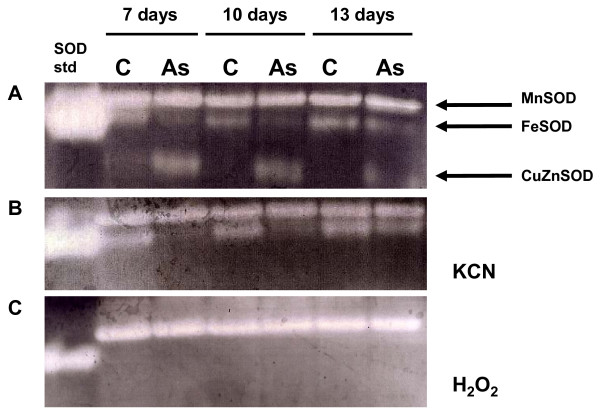
SOD activity in Arabidopsis thaliana 'Col' grown on medium containing 100 μM potassium arsenate. A, superoxide dismutase activity without inhibitors, B, Gels were preincubated with KCN (which inhibits CuZn SOD), C, H2O2 added as an inhibitor (which inhibits both CuZn SOD and Fe SOD). Lane 1, purified bovine SOD positive control. Lane 2, control plants harvested at 7 days, Lane 3, arsenate-treated plants harvested at 7 days. Lane 4, control plants harvested at 10 days, Lane 5, arsenate-treated plants harvested at 10 days. Lane 6, control plants harvested at 13 days, Lane 7, arsenate-treated plants harvested at 13 days.